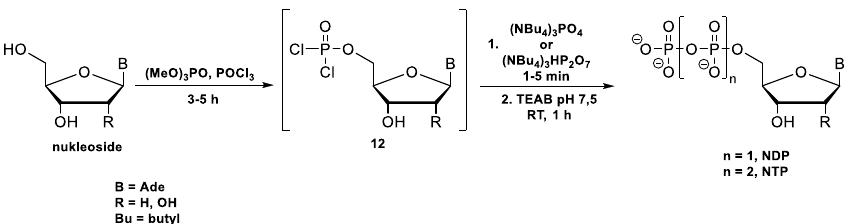
Scheme 9. The synthesis of nucleoside 5 (cid:48) -di- and triphosphates via dichlorophosphate intermediate